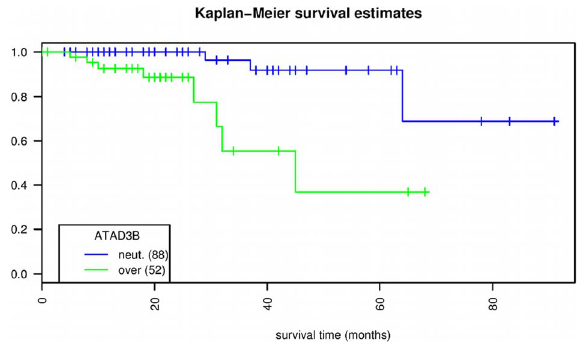
Figure 4. Kaplan-Meier survival plot comparing TCGA patients with over-expression (52 patients) or neutral expression (88 patients) of ATAD3B . Vertical ticks represent censoring events. The X and Y axes represent follow-up time in months and the percentage of survival, respectively. The associated log-rank p-value is p v 5 : 1 | 10 { 4 .